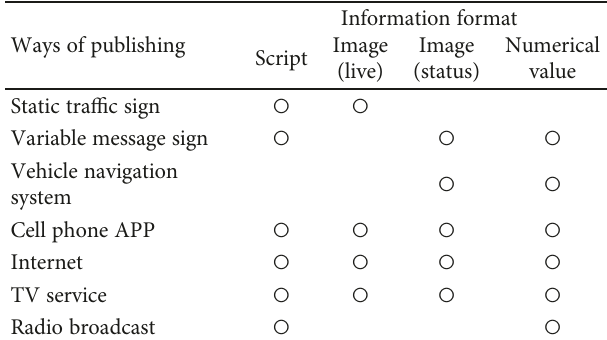
Table 2: Information